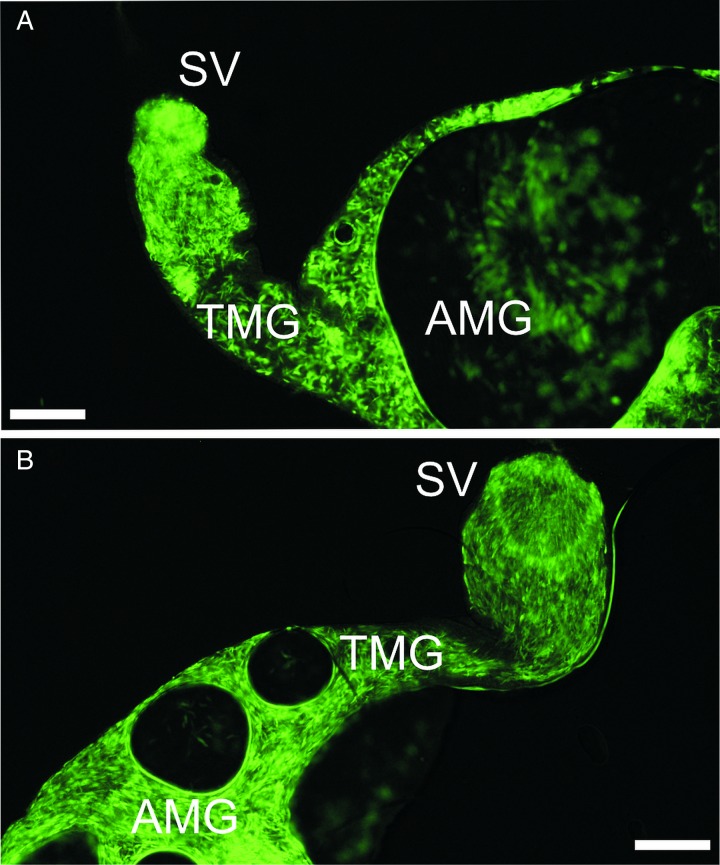
Images from fluorescent microscope showing amastigote-initiated (A) and promastigote-initiated (B) L. donovani infections in P. argentipes females by day 4 PBM. Parasites (transfected with GFP) are present in both abdominal and thoracic parts of the midgut and the stomodeal valve is colonized. AMG, abdominal midgut; TMG, thoracic midgut; SV, stomodeal valve. Scale bar = 100 µm.